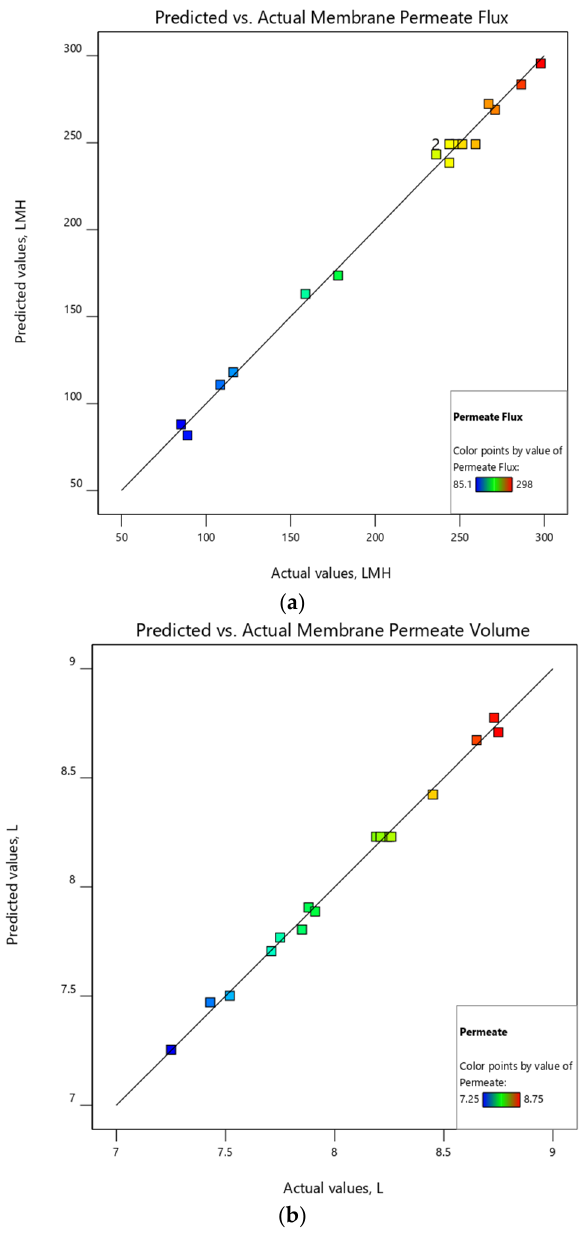
Figure 2. Membrane predicted values versus the actual value. ( a ) Permeate ‐ predictive flux model and ( b ) permeate ‐ predictive volume model for the experiment.